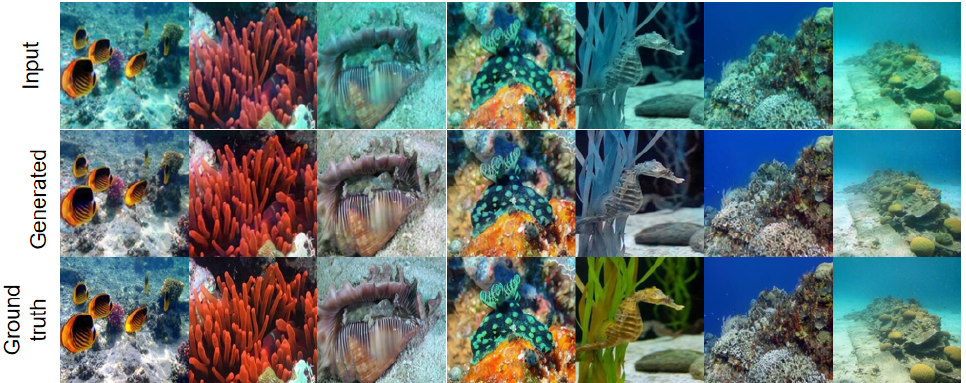
Figure 6. Several generated results of the EUVP